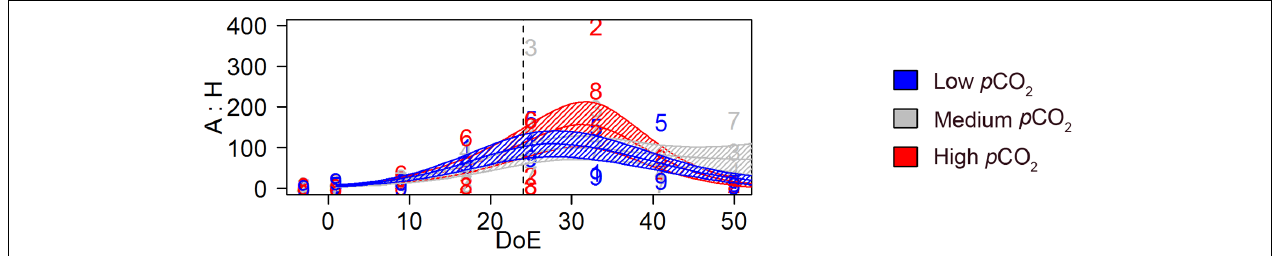
FIGURE 9 | Trophic transfer efficiency; autotrophy versus heterotrophy (A:H). Autotroph: heterotroph biomass ratio based on biomass estimations ( µ g C L − 1 ). Color code: blue = low- p CO 2 (M1, M5, and M9), gray = medium- p CO 2 (M3, M4, and M7), red = high- p CO 2 (M2, M6, and M8). DoE, day of experiment. Solid lines = prediction from Generalized Additive Mixed Models (GAMMs) (smoother trends p -value < 0.05); shaded area = confidence interval. Dashed line: t24, deep water